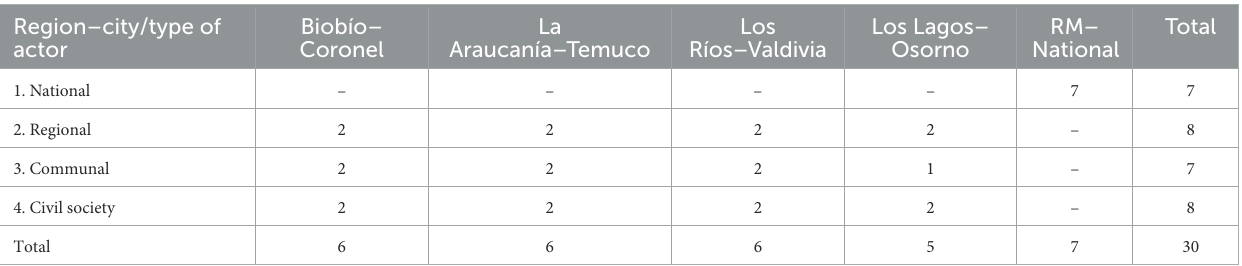
TABLE 2 Total number of interviewees per type of actor and city/region.